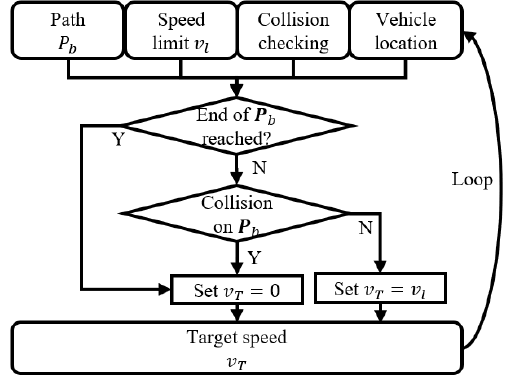
(21) Figure 12. An example of collision risk preference. 4.4. Speed Profile Generation The speed profile generation is an essential part of autonomous driving systems, it generates a feasible profile based on the speed limit, and collision probability with dy- namic or static obstacles, which cannot be ignored. This work focuses on the path planning process for autonomous vehicles running on half structured roads with a maximum speed